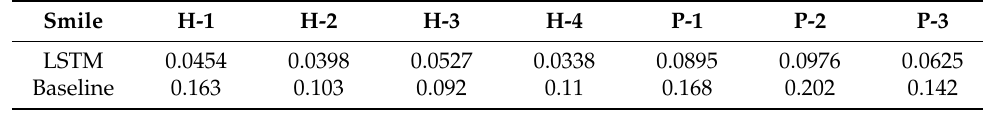
Table 2. RMSE for the test dataset.